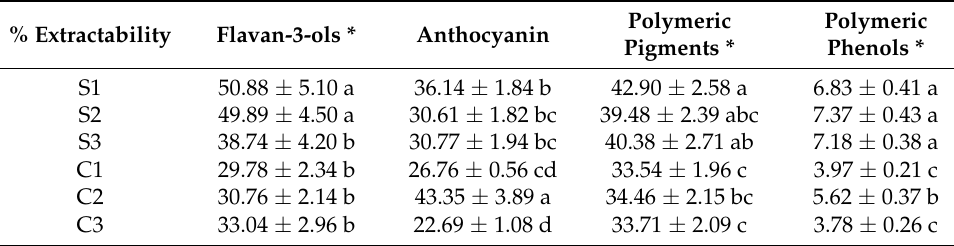
Table 3. Percentage extractability of different phenolic classes as calculated for all the samples